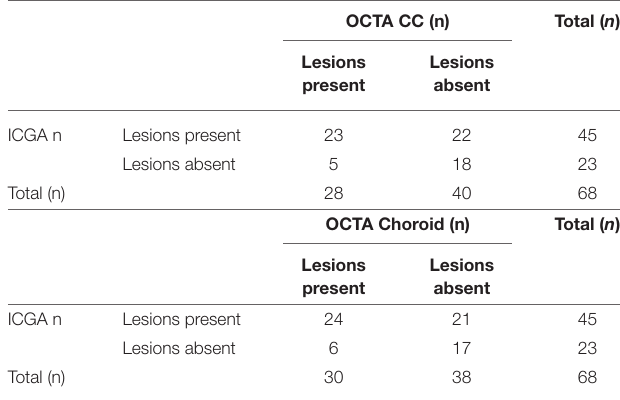
TABLE 2 | Cross table presenting the prevalence of non-perfusion visible on ICGA and